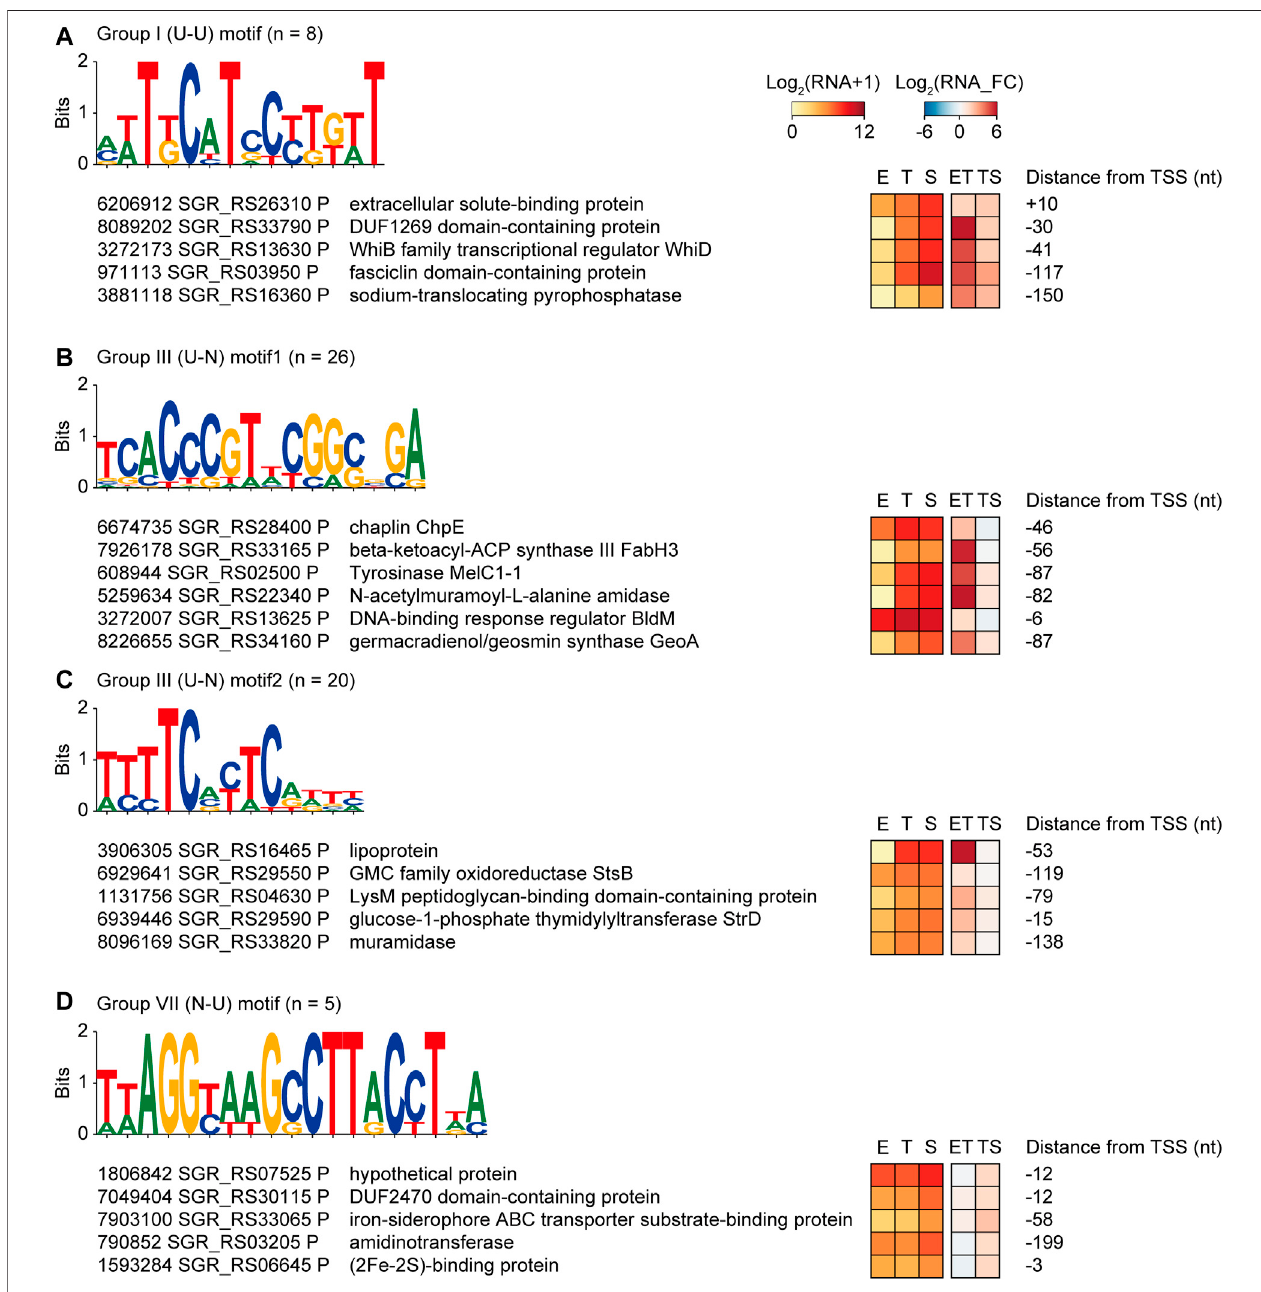
FIGURE 4 | Four examples of potential transcription factor binding motifs found from genes of the same transcription pattern groups, which are (A) group I (U – U), (B,C) group III (U – N), and (D) group VII (N – U). Conserved motifs were detected by MEME with zoops parameter. The fi ve or six promoters were selected based on the gene functions. RNA expression levels, fold changes, and distance from the TSS were also